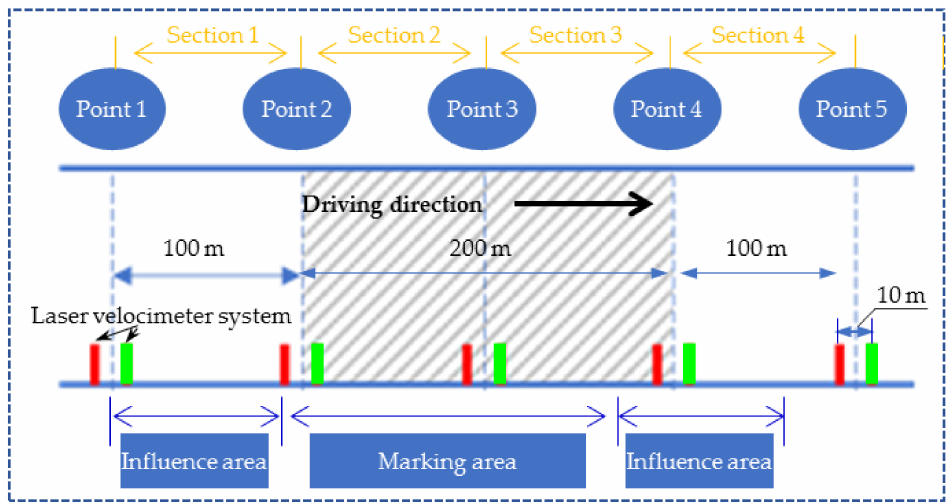
Figure 8. Assessing vehicle speeds controlled by